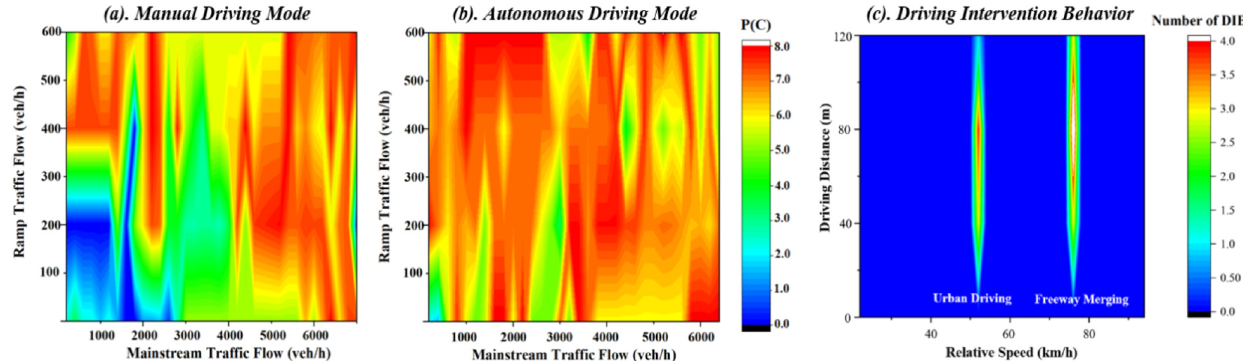
Figure 13 Difference of the con fl ict probability concerning freeway merging between manual (a) and AV (b) modes: and DIB during the experiment